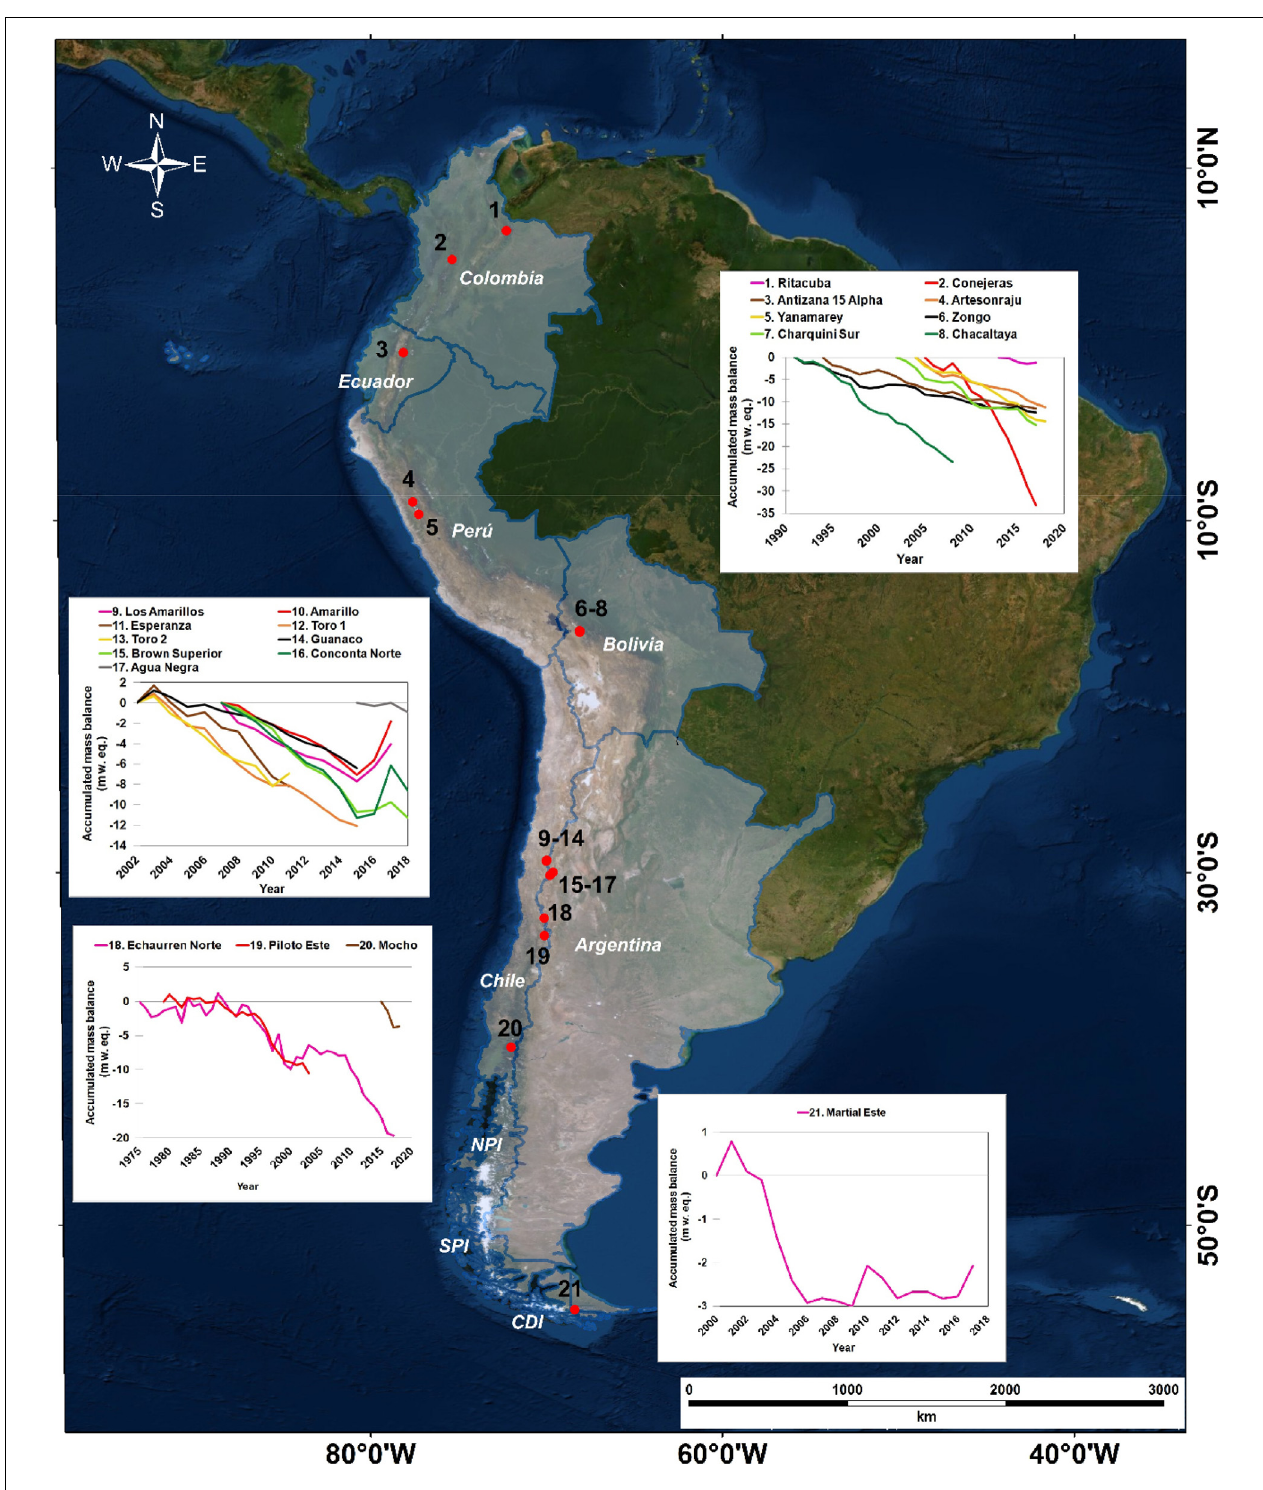
FIGURE 2 | Location of the glaciers with long ( > 5 years) series of mass balance measurements in the Andes. Note that only the Echaurren Norte series is longer than 30 years. Source: Official glacier mass balance data provided by the national correspondents and published by the World Glacier Monitoring Service